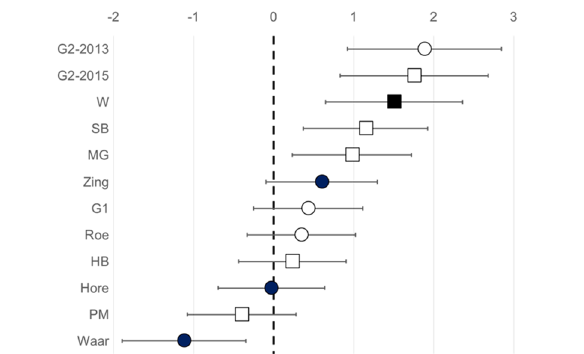
Figure 2. Cohen’s d effect size are positive when the bumble bee nest biomass increase in apiary sparse (AS) sites is greater than in apiary dense (AD) sites (a proxy for higher nest fitness). Circles represent the dataset of 2013, while squares represent the dataset of 2015. The filled circles represent locations dominated with agricultural landscape elements. In each location (n = 12; 6 in 2013 and 6 in 2015) we had 2 × 3 B. terrestris nests (n = 72). Linear mixed-effects models are performed on individual data points (this is 3 nests per site, 2 sites (AD and AS) per location, 6 locations per year and 2 years or 3*2*6*2 = 72 data points) and not on Cohen’s d effect sizes, which are for visualization purpose only. To calculate the effect size between AS and AD sites we used the Cohen’s d formula 46 .